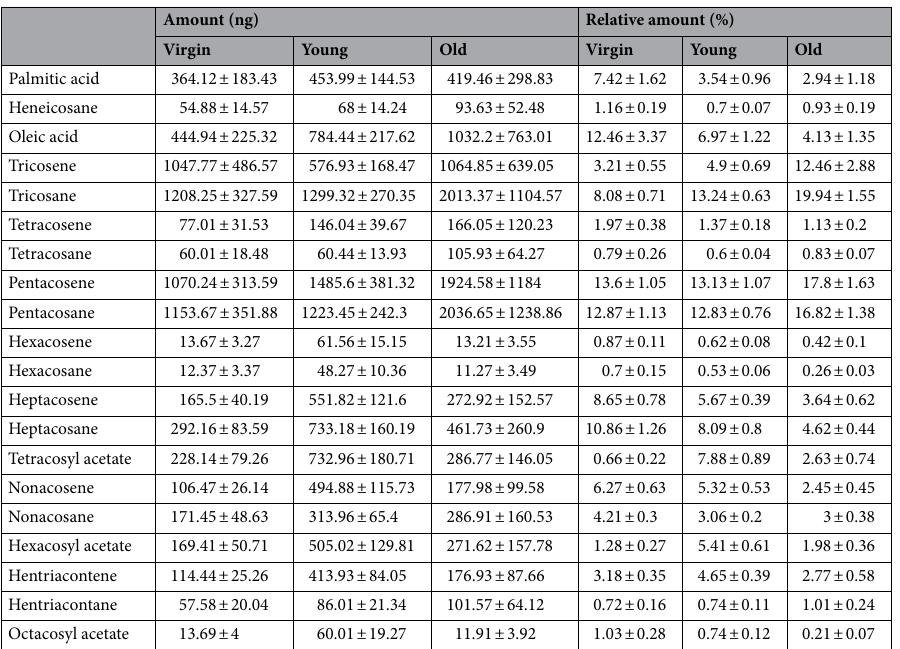
Table 2. Absolute (ng) and relative amounts (%) of compounds in cuticular extracts of queens. Data were collected from 13 pools (4 pools of virgin, 5 pools of young, and 4 pools of old queens, each pool contained 10 queens) and 36 individual samples (9 virgin, 19 young, and 8 old queens). Data are presented as mean ±